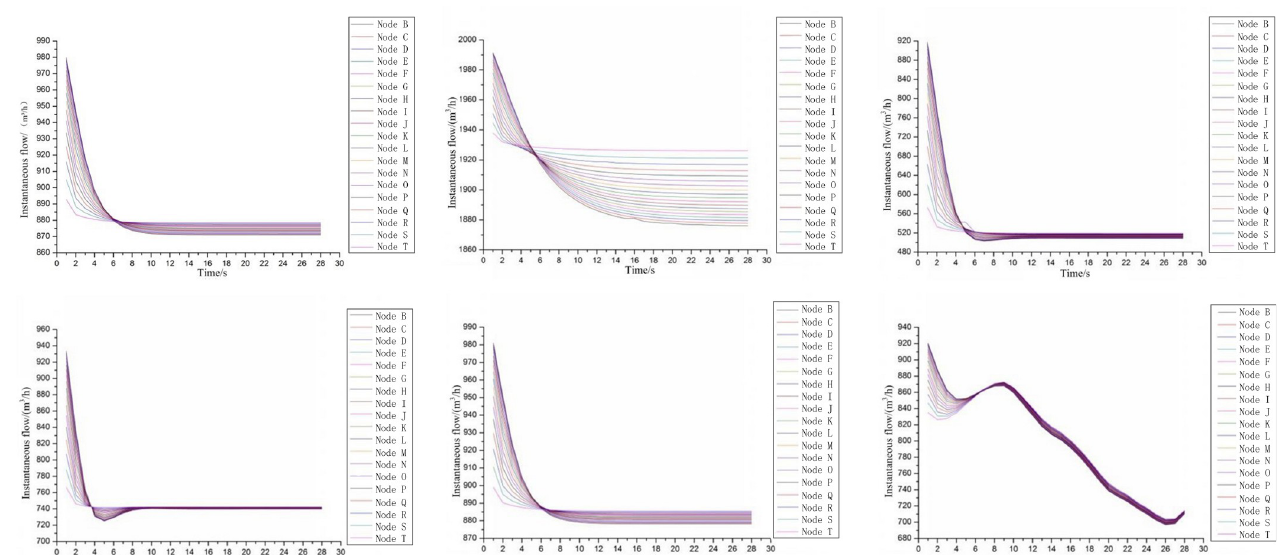
Fig 2. The user side flow rate changes by second under leakage condition. (a) Under leak condition 1, (b) Under leak condition 2, (c) Under leak condition 3, (d) Under leak condition 4, (e) Under leak condition 5, (f) Under leak condition 6.